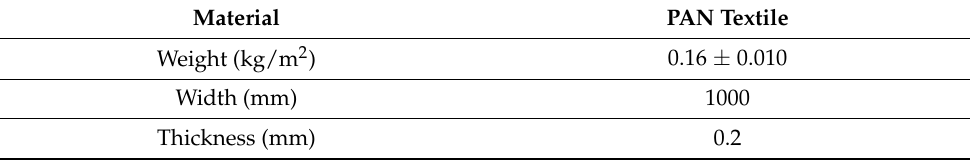
Table 3. Technical data sheet of PAN textile grid provided by the